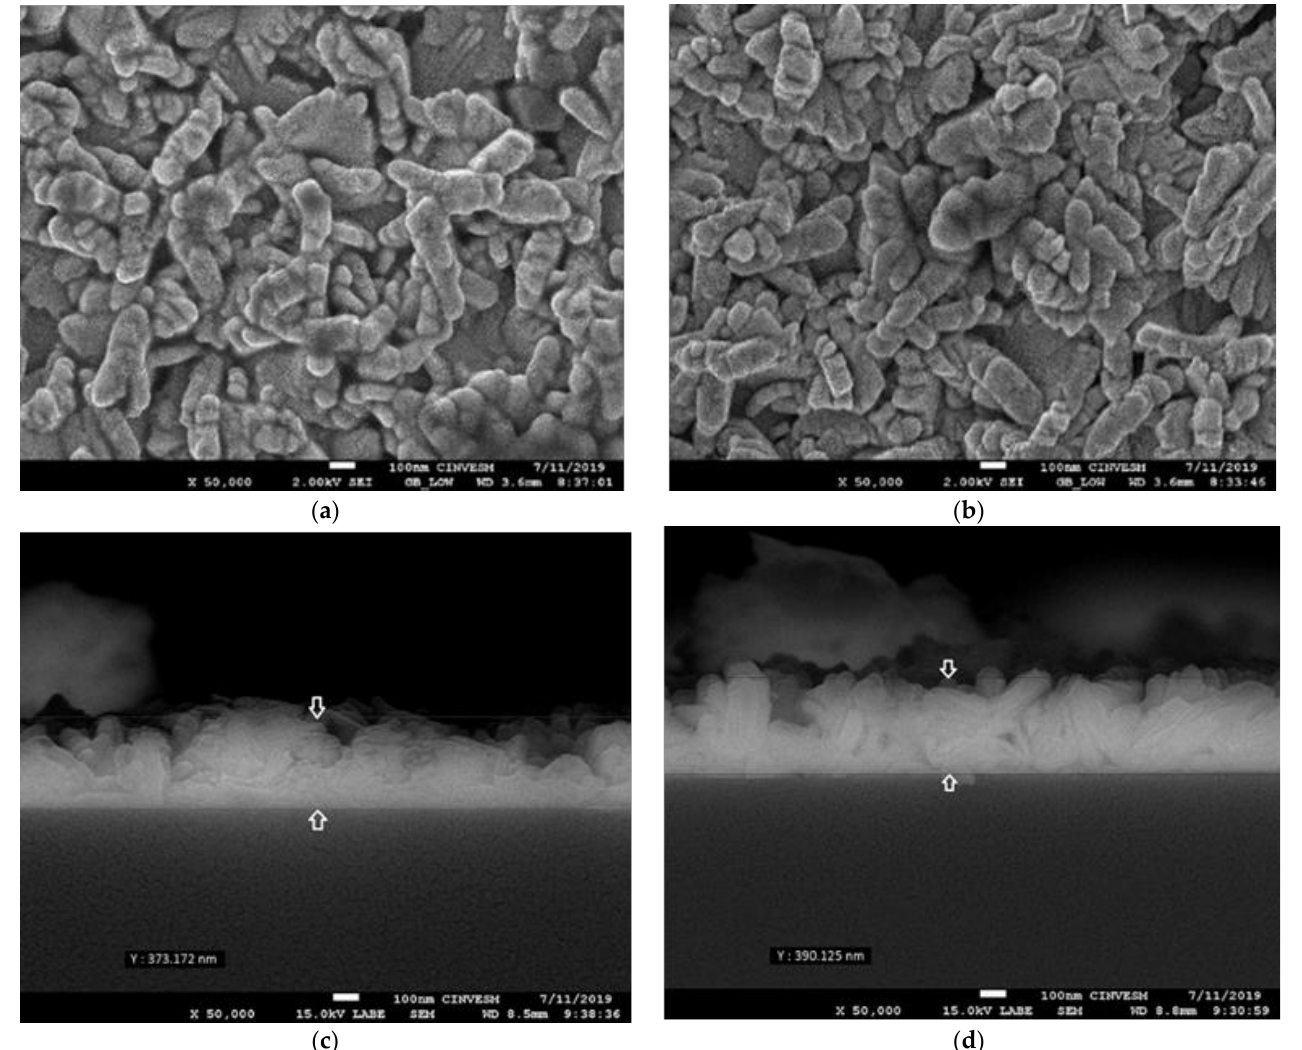
Figure 2. SEM micrograph for sample S3 ( a ) with and ( b ) without port-annealing and cross-section of samples ( c ) S2 and ( d ) S3.